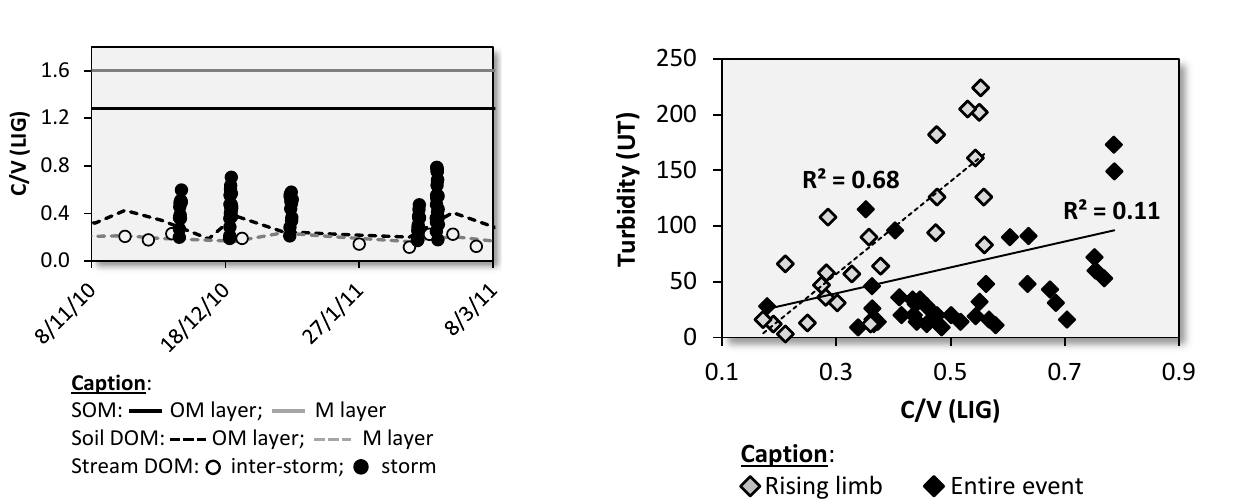
Figure 6. Correlation between turbidity and the C / V ratio (lignin proxy) during the rising limbs (grey diamonds – p value < 0.0001) and during entire storm events (black diamonds – p value =